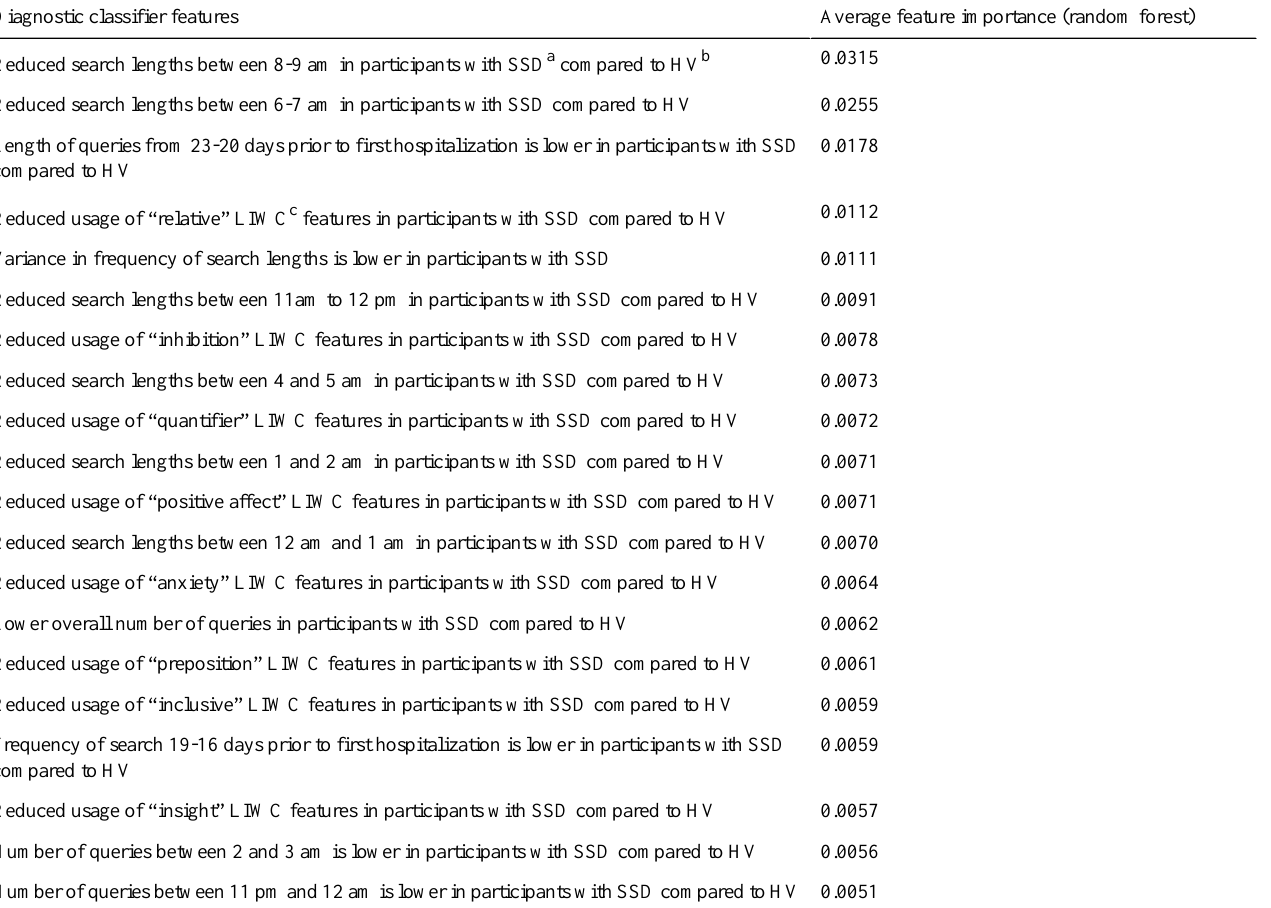
Table 7. Feature importance of diagnostic classifiers sorted by decreasing order of importance.